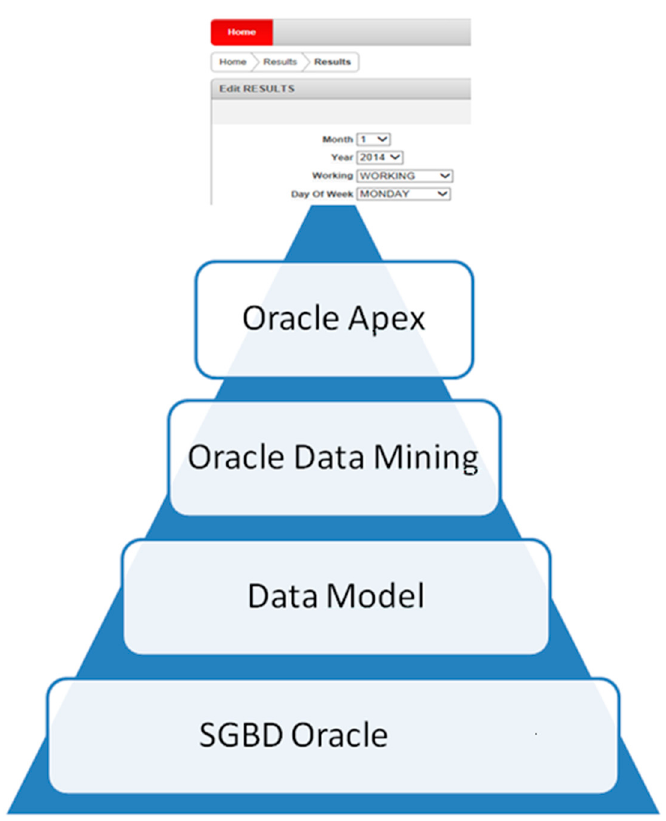
Figure 3. Decision support system architecture.